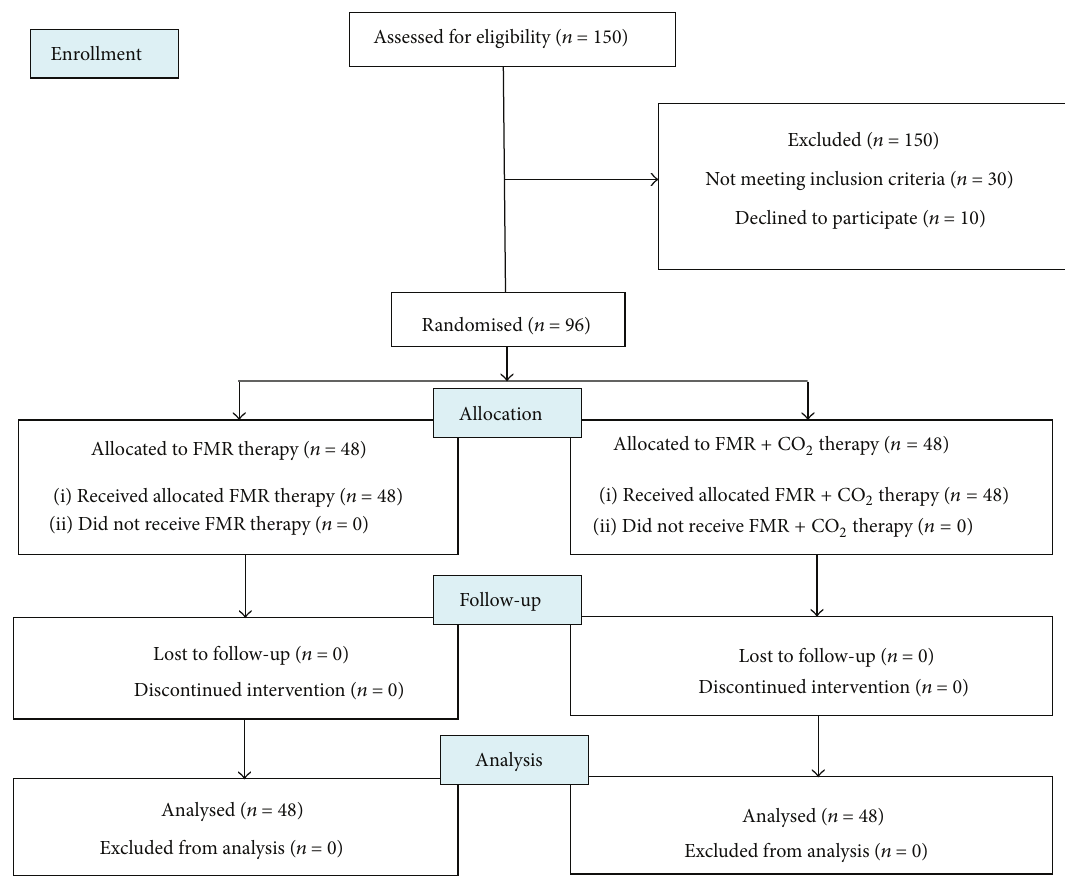
Figure 1: CONSORT flow chart of the study.